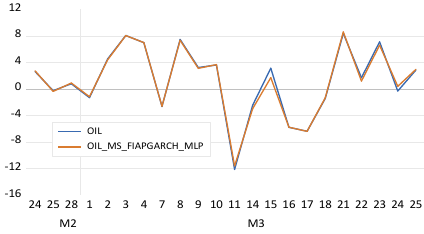
Figure 6. Oil, MS−FIAPGARCH. -6-4-2024 6810 24 25 28 1 2 3 4 7 8 9 10 11 14 15 16 17 18 21 22 23 24 25 M2 M3 PLATINUM PLATINUM_MS_FIAPGARCH_MLP Figure 7. Platinum, MS−FIAPGARCH−MLP.